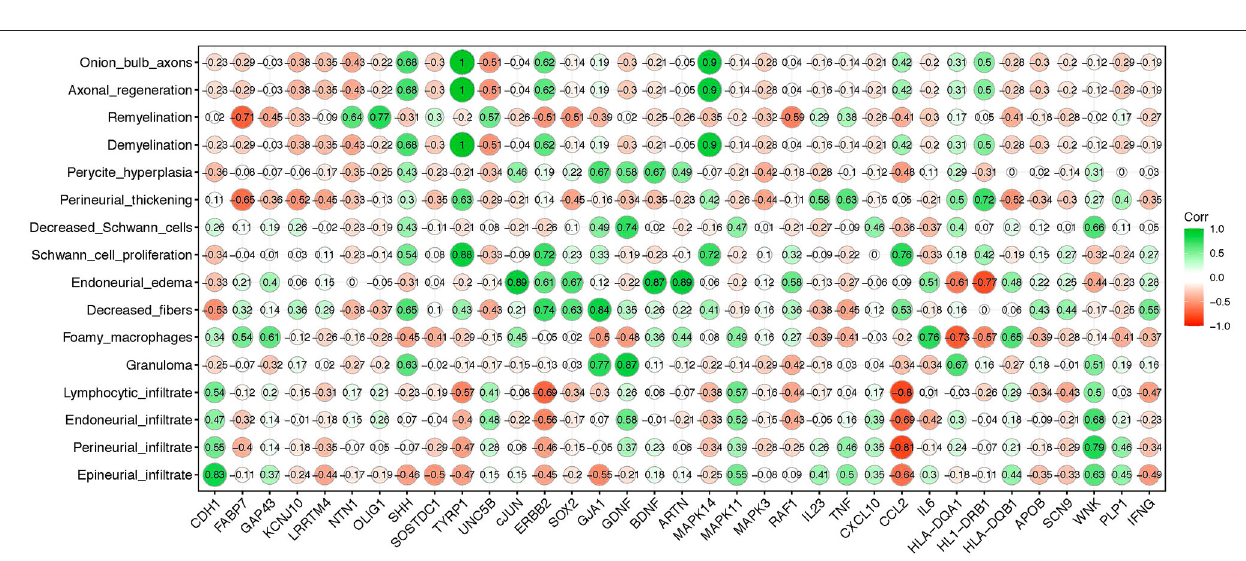
FIGURE 5 | Correlation matrix between leprosy histopathological alterations and gene expression profile in PNL patients. The y-axis indicates major nerve histopathological alterations observed in leprosy patients; the x-axis shows Schwann cell genes evaluated in PNL patients. The green color (closer to 1 value) means stronger correlation while the red color (closer to − 1 value) means weaker correlation between the gene expression and the specific histopathological alteration,